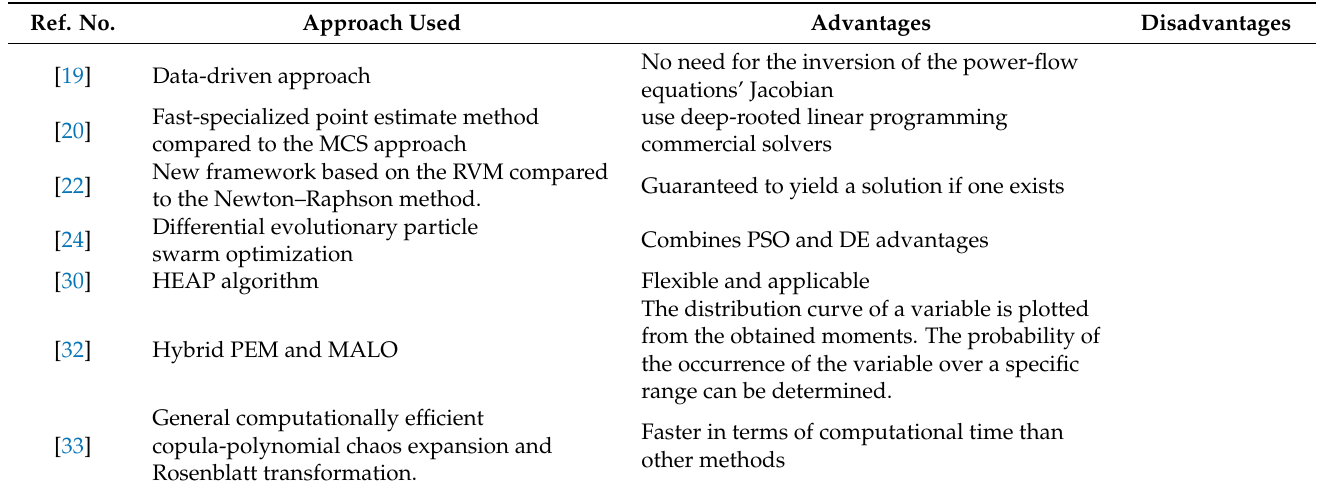
Table 1. Summary of some of the references stated in the